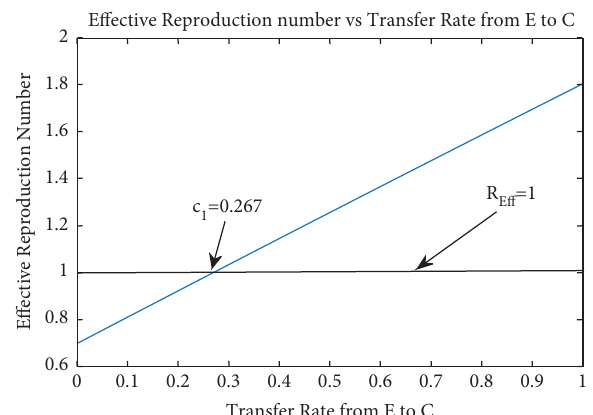
Figure 3: Behavior of effective reproduction number in relation to